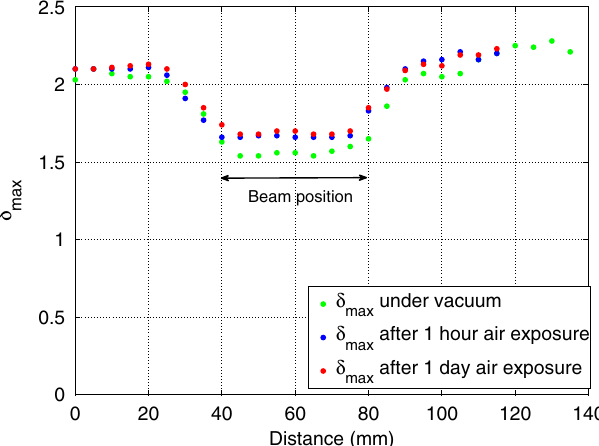
FIG. 8. SEY measurement in the lab on the removable StSt sample transferred from the SPS to the measuring system under vacuum.